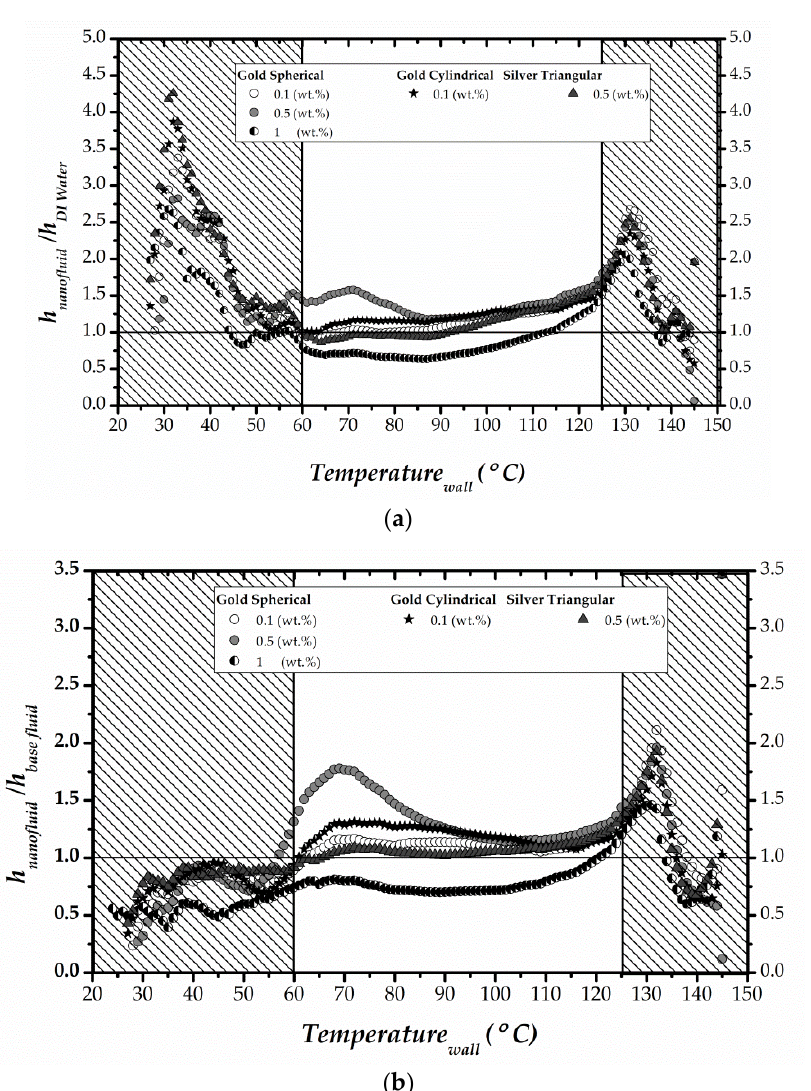
Figure 11. Ratio between the heat convection coefficient obtained between the various nanofluid sprays and ( a ) DI water, ( b ) DI water, and CTAB.